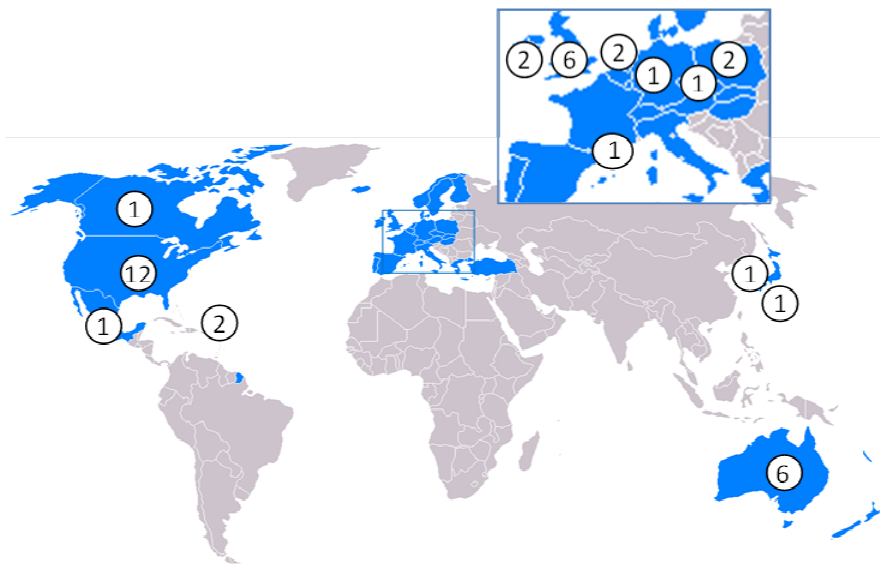
Figure 3. Number of studies identified for each OECD country. NB There were studies of Europe and US [48] and worldwide [1] that are not